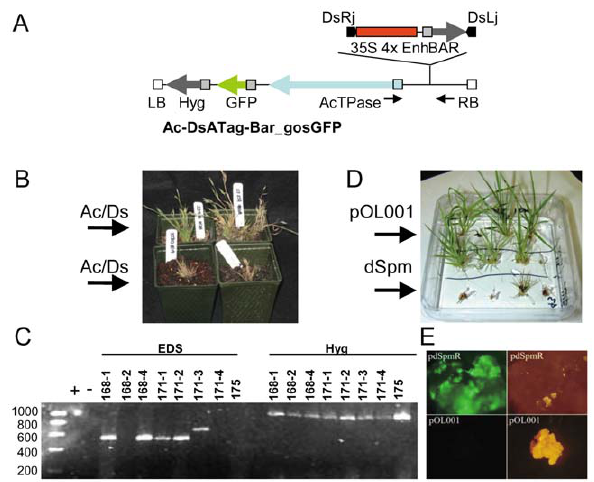
Figure 2. Evaluation of transposon tagging in Brachypodium . A. Diagram of the T-DNA region of Ac-DsATag-Bar_gosGFP. The mobile element is depicted on the upper line. Note that when the mobile element excises the empty donor site (EDS) can be amplified by the flanking PCR primers, solid black arrows. B. Examples of transgenic plants created using Ac-DsATag-Bar_gosGFP. Most plants containing the transposable elements died before flowering or failed to set seed. C. PCR using primers that flank the Ds mobile element. An EDS produces a band while an intact donor site will not produce a band. Note that five of eight lines contain an EDS indicating that Ds was excised. The hygromycin resistance gene was amplified from all lines indicating that they contained at least part of the T-DNA. D. Examples of transgenic plants created using the pdSpm-R tagging construct and the control vector pOL001. Most plants containing the transposable elements died when very small. E. Calluses transformed with the pdSpm-R tagging construct were fluorescent green due to the expression of GFP contained on the T-DNA. By contrast, calluses transformed with a control plasmid, pOL001, were not fluorescent. For both constructs, pictures on the left are taken under UV light through a GFP filter and the pictures on the right are under white